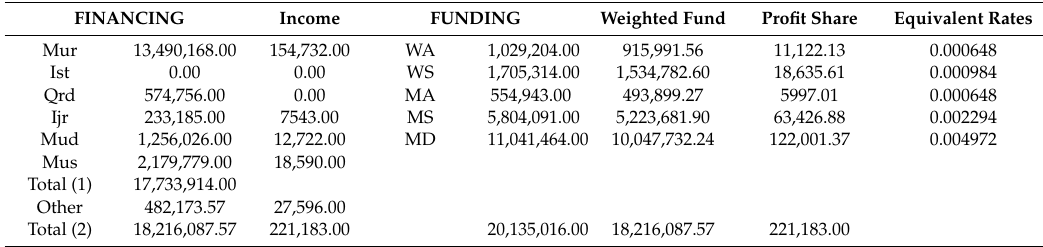
Table 4. Jan 2016 balance sheet of Bank C (IDR,